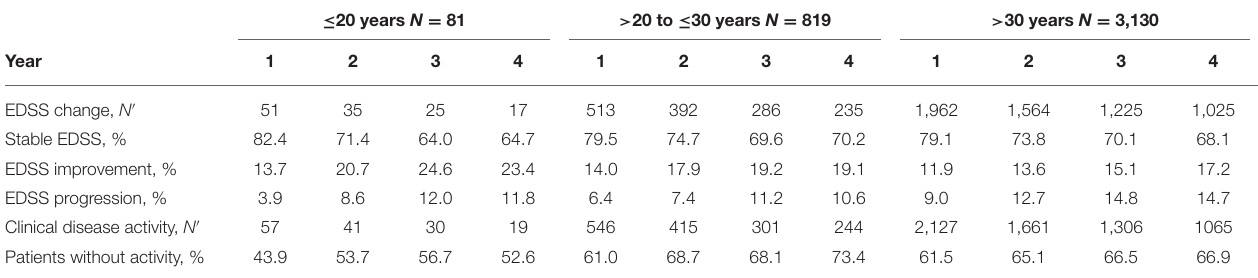
TABLE 3 | EDSS change and clinical disease activity per year (not aggregated).